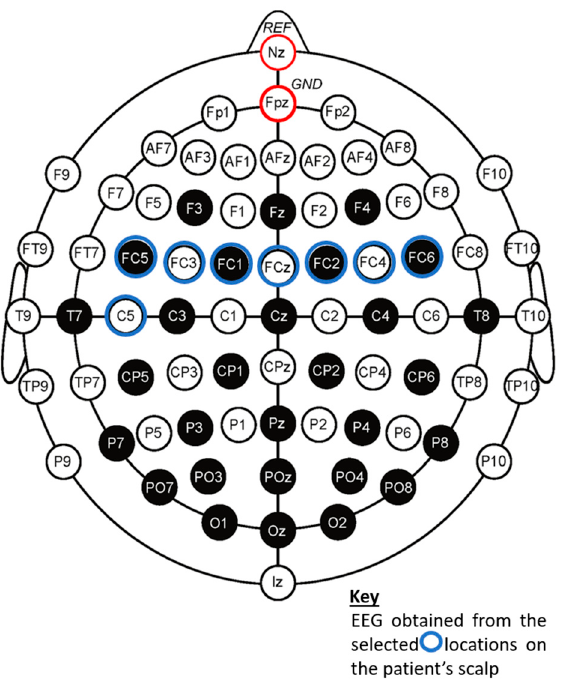
Figure 5. Arrangement of electrodes used to obtain the electroencephalogram (EEG) signals used in the analysis.